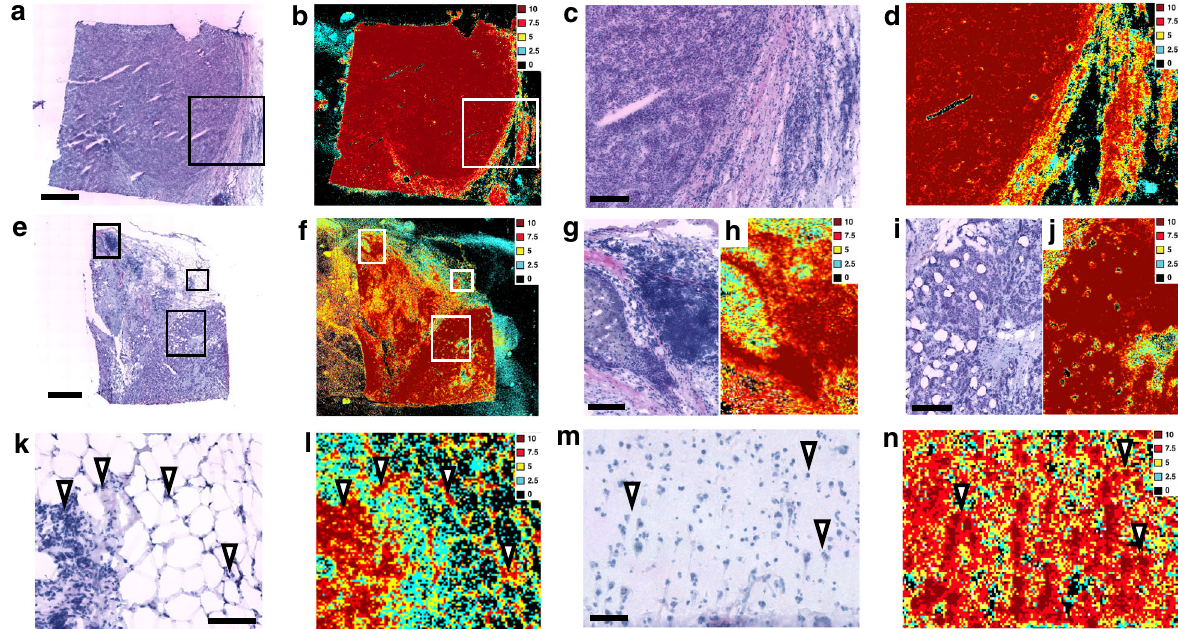
Fig. 3 Application of the sRIN assay on well-preserved clinical samples. a – l Luminal B breast tumor tissue sections from two patients ( n = 3, technical replicates each). a HE image (scale bar: 1 mm) and b sRIN heat map, boxes enclose regions shown in close-up. Close-up of c HE image (scale bar: 200 µ m) and d sRIN heat map. e HE image (scale bar: 1 mm) and f sRIN heat map, boxes enclose regions shown in close-up. Close-up of g HE image (scale bar: 150 µ m) and h sRIN heat map. Close-up of i HE image (scale bar: 200 µ m) and j sRIN heat map. Close-up of k HE image (scale bar: 100 µ m) and l sRIN heat map, arrows show areas of very high (10) sRIN values and varied cell density. m HE image (scale bar: 80 µ m) and n sRIN heat map of a gray matter region from a post-mortem brain ( n = 3, biological replicates).